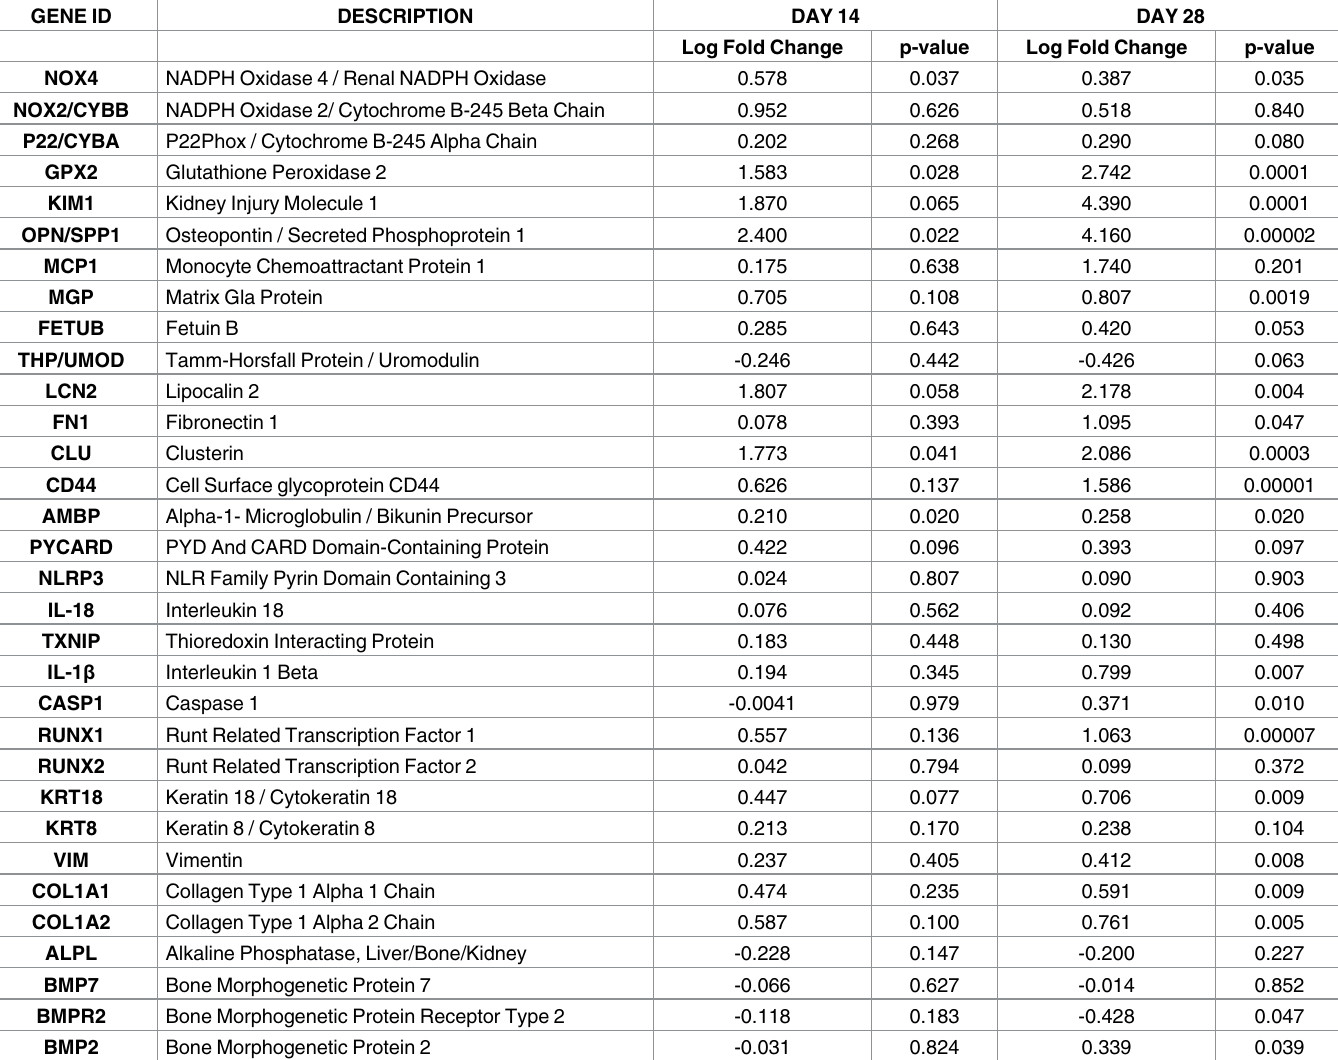
Table 6. Relative expression of important genes in ethylene glycol (EG) fed rat vs control group, along with their p-values derived from microarray analysis and data mining. GENE